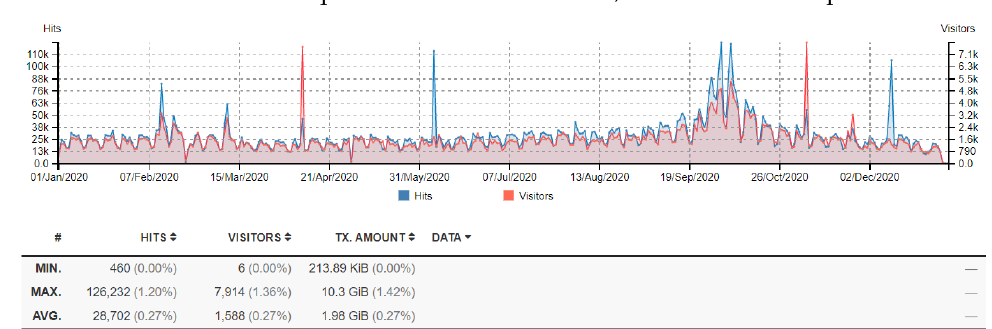
Figure 12. Institutional website—2020 access stats.